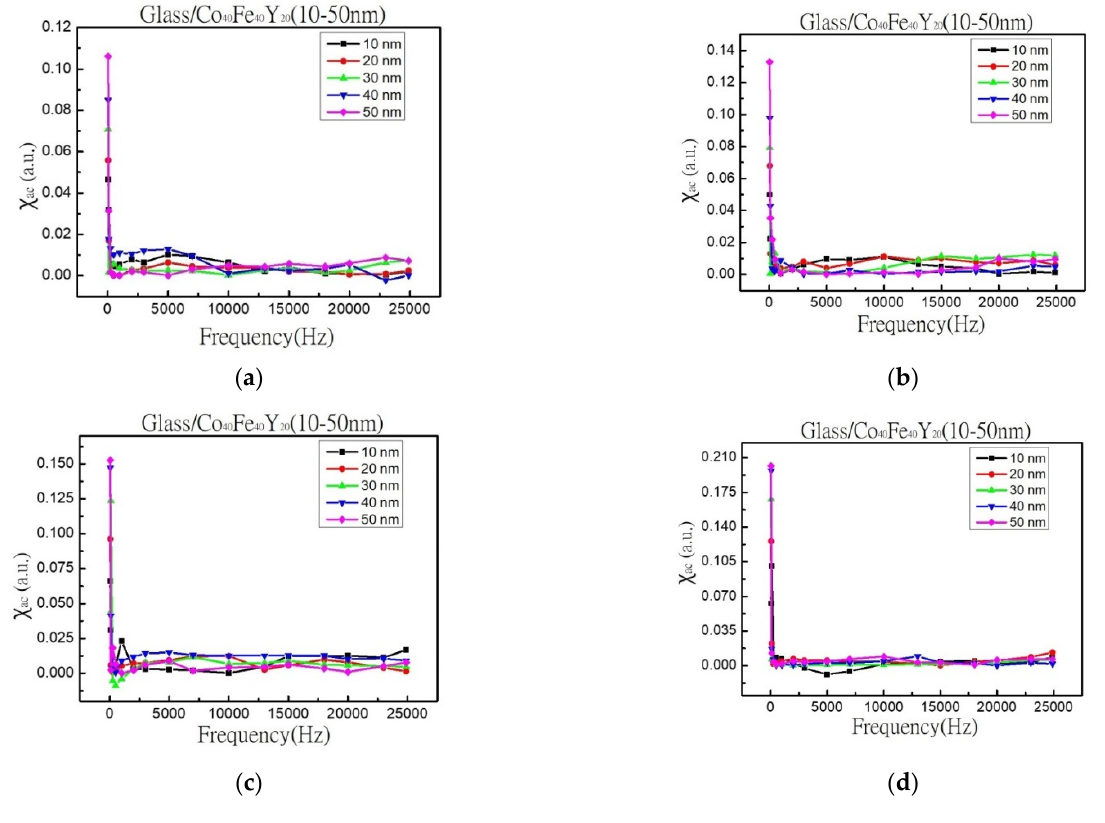
Figure 4. χ ac result as a function of the frequency from 50 to 25,000 Hz. ( a ) RT, ( b ) after annealing at 100 ◦ C, ( c ) after annealing at 200 ◦ C, ( d ) after annealing at 300 ◦